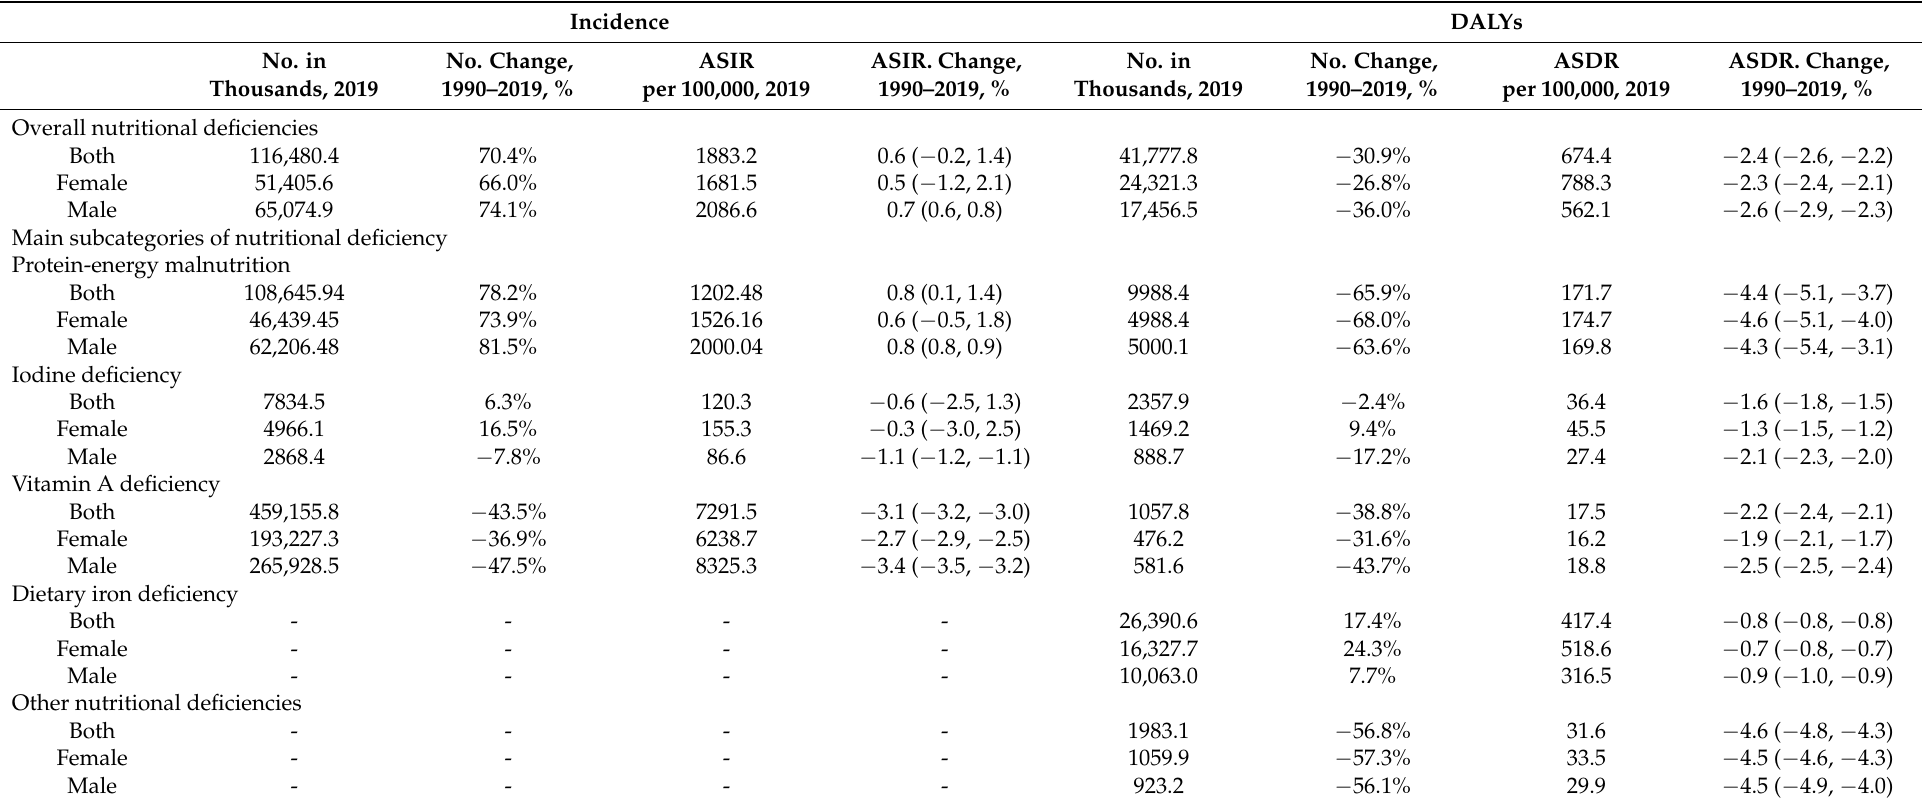
Table 1. Sex-Specific incidence and DALYs numbers, age-standardized rate per 100,000 for nutritional deficiencies (NDs) and its main subcategories, and their trend from 1990 to 2019 in